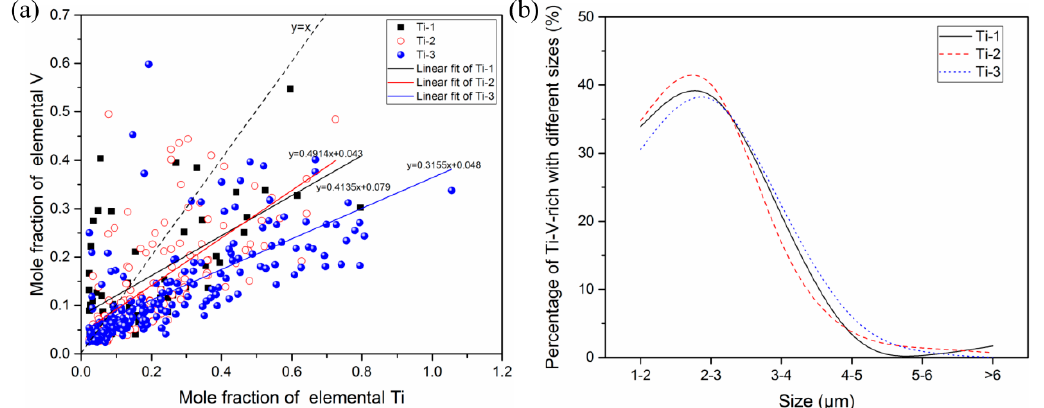
Figure 7. Composition ( a ) and size ( b ) of Ti–V-rich carbide inclusions in the samples.